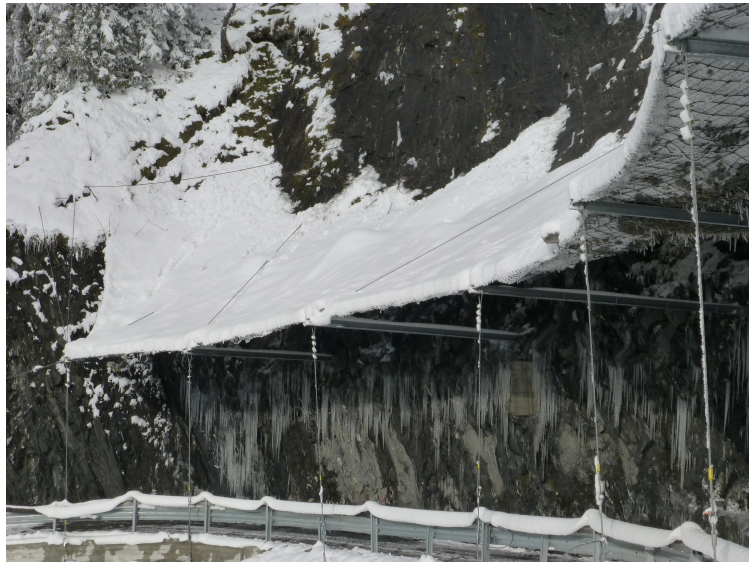
Figure 3. Rockfall protection barrier suffering from snow